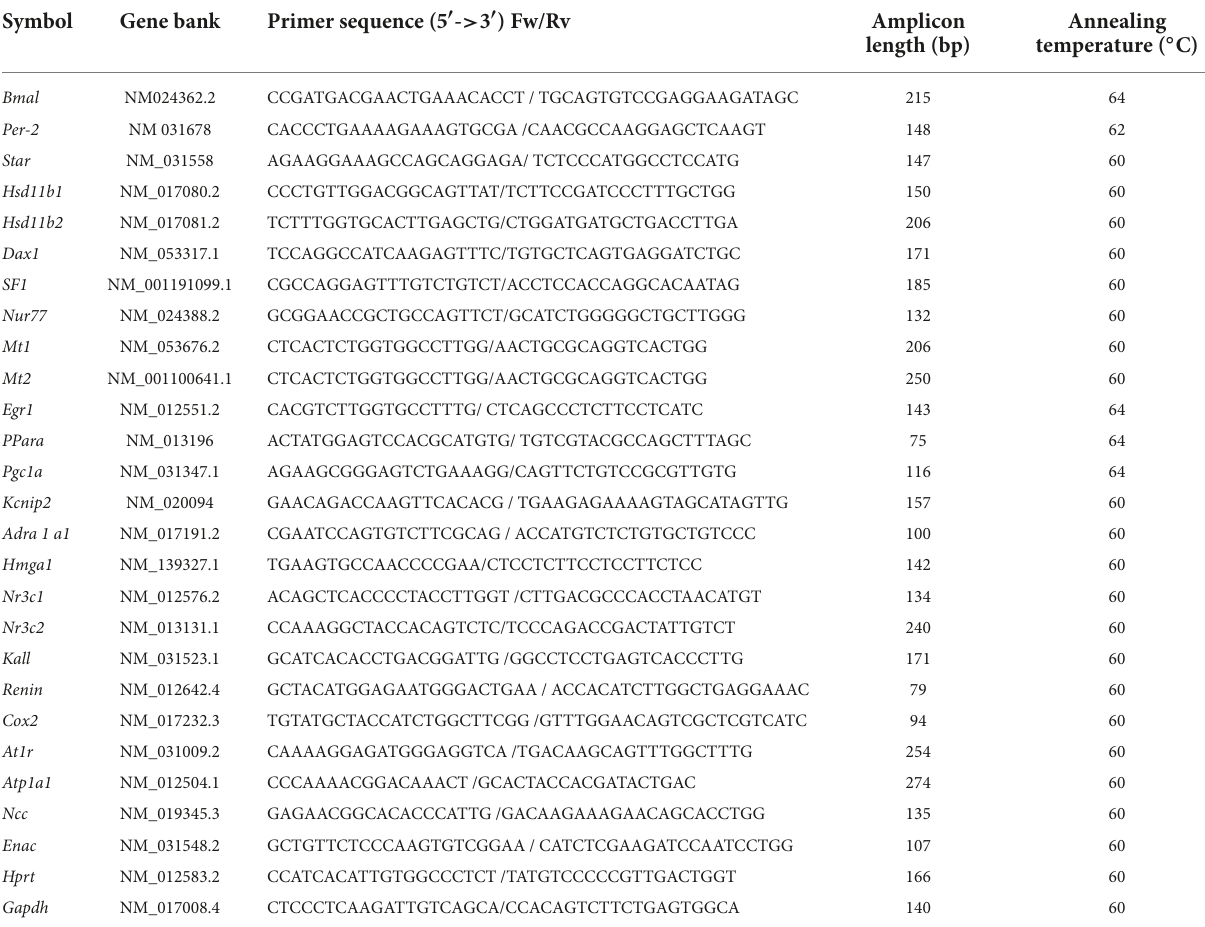
TABLE 1 Primers used for RT-qPCR studies.